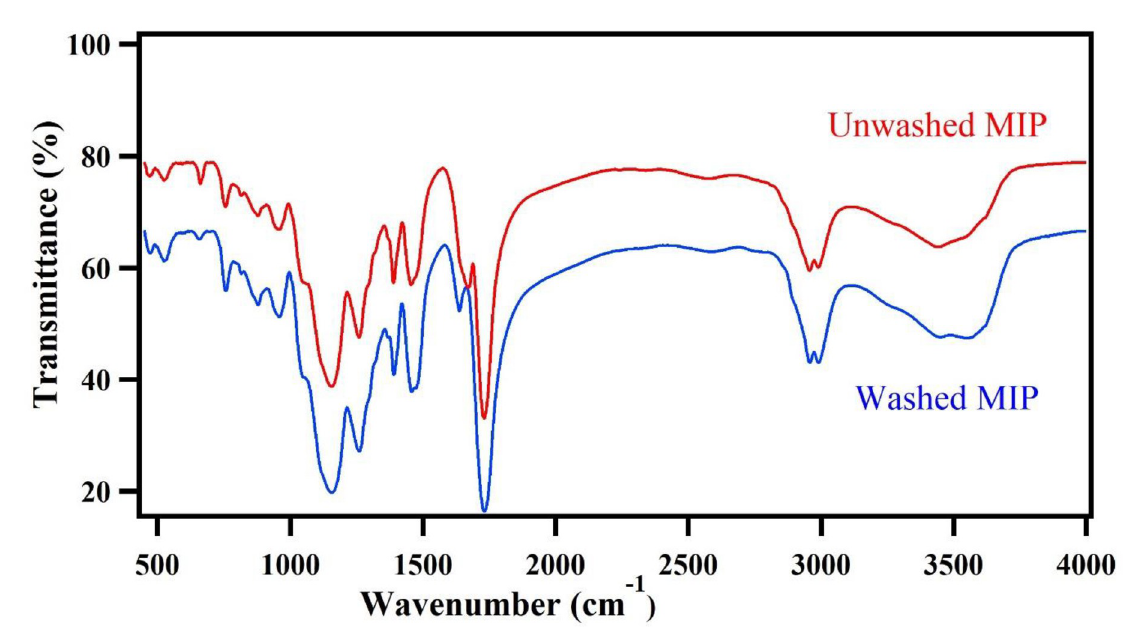
Fig 4. The voltammograms of MWCNTs-MIP-CPE, MWCNTs-NIP-CPE, and CP for CBZ sensor in CBZ 1.0 × 10 − 7 mol mol L − 1 . (Supporting electrolyte: phosphate buffer 0.1mol mol L − 1 ) (Scan rate: 100 mV/s).